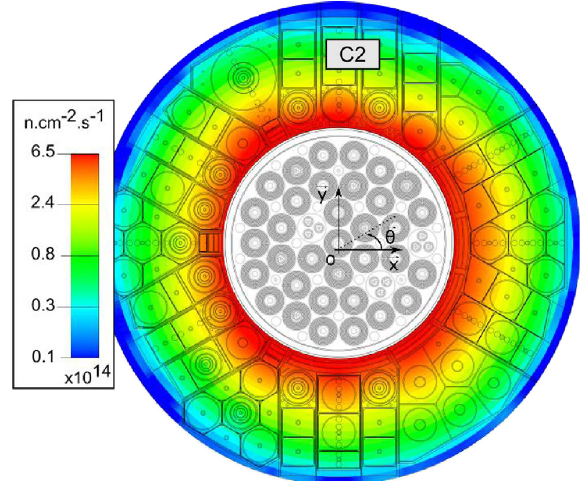
Fig. 10. Thermal fl ux distribution. Values are taken in the axial center of the core, integrated axially over 5cm.